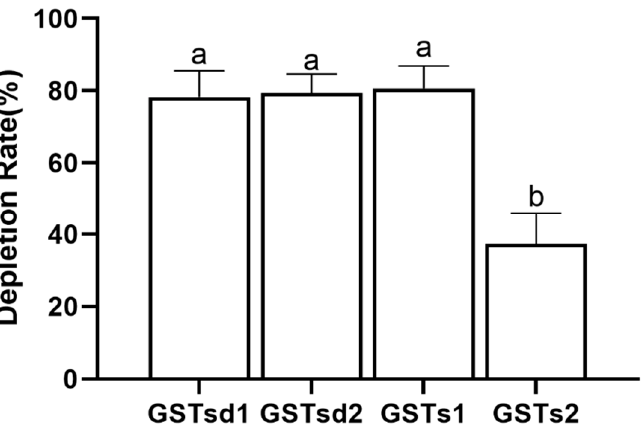
Figure 4. Inhibition of (S)-( − )-palasonin on GSTs protein. (Bars indicate means ± standard errors of replicates. Asterisks indicate statistically significant variances (one-way ANOVA and Tukey’s multiple comparison test were used; **, p ≤ 0.01.).